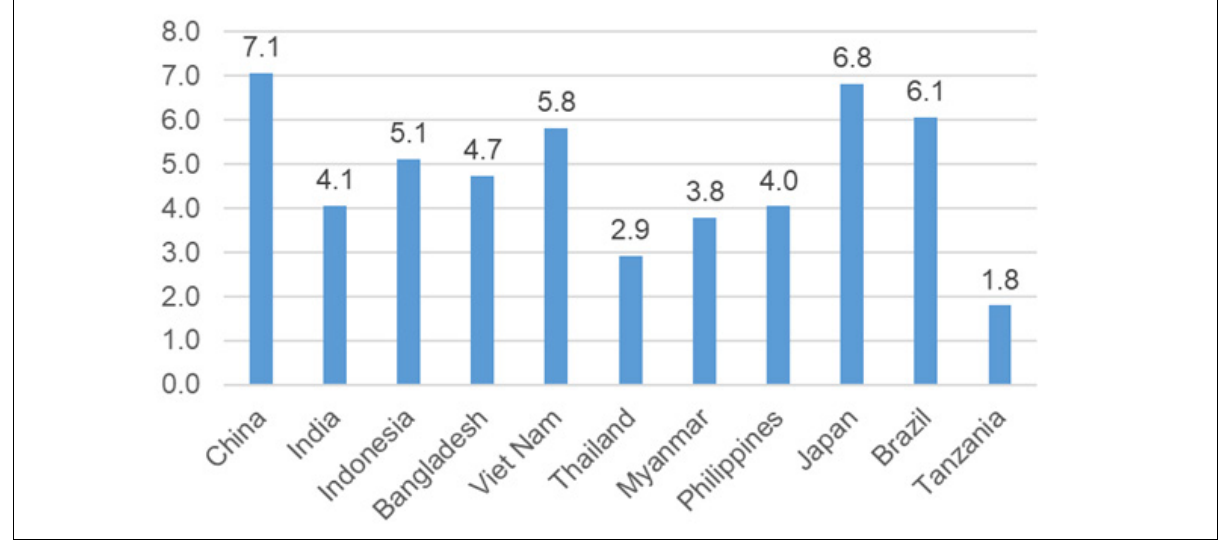
Data source: FAOSTAT 25 Figure 2: Comparison of yield/productivity (tonnes/ha) of major rice-producing countries and Tanzania for the year 2019.